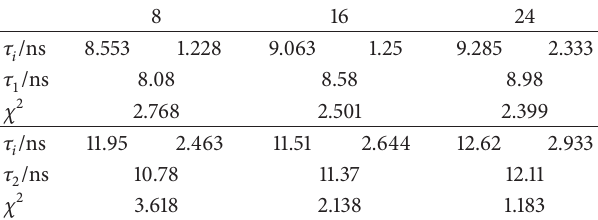
Table 1: Lifetimes of luminescent thin films based on MgAlLa- LDHs. 𝜏 1 stands for the lifetime of Mg( 𝑛 )-films and 𝜏 2 stands for the lifetime of MgM( 𝑛